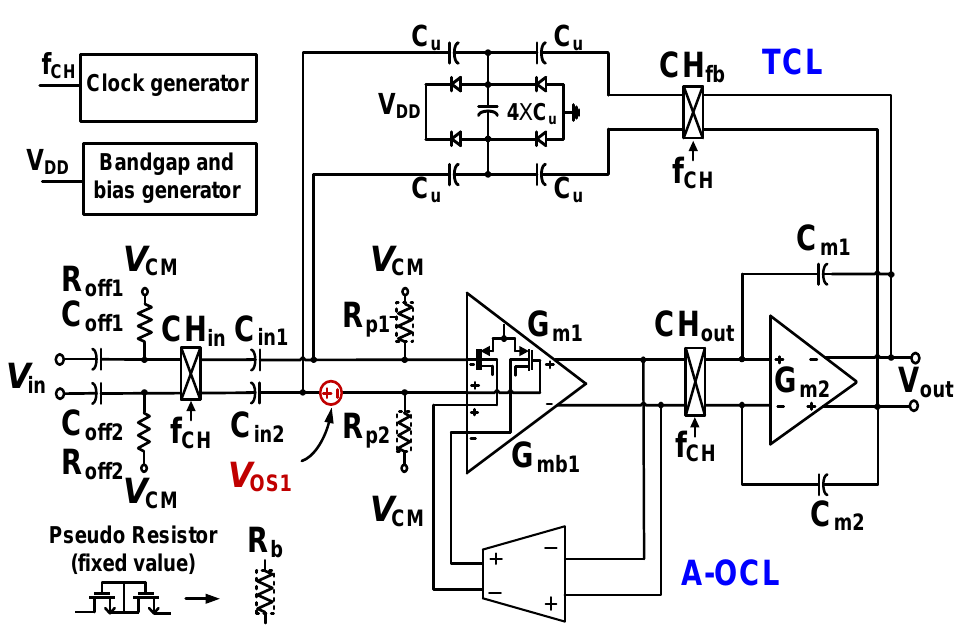
Figure 2. Schematic of the proposed CCIA using A-OCL. C in1,2 = 2 pF, C fbeq1,2 = 20 fF, C m1,2 = 1.5 pF. The common-mode voltage V CM is set to 0.5 V for G m1 through two